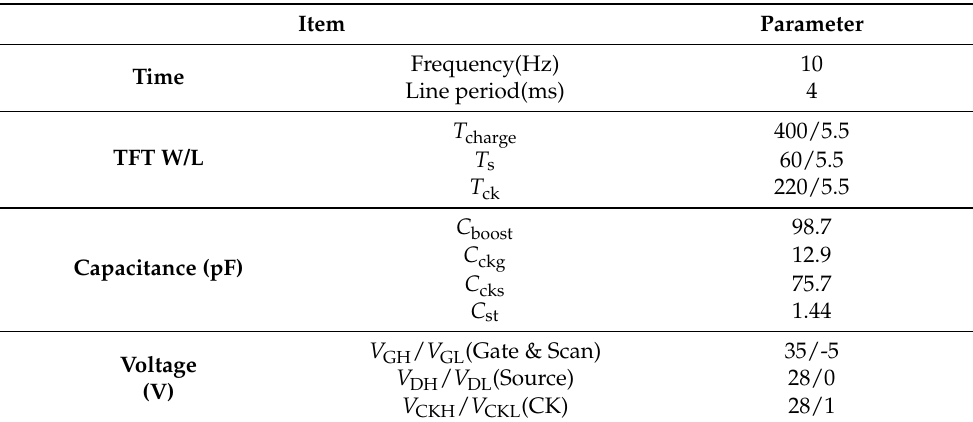
Figure 5. Simulation result of ( a ) pixel charging and holding process of 1T1C pixel, ( b ) max pixel voltage of the 3T4C pixel with different line period, ( c ) pixel charging and holding process of 3T4C pixel with 4ms line period, and ( d ) pixel charging and holding process of 3T4C pixel with 0.25 ms line period. Table 3. Key parameters used for simulation of pixel with boost